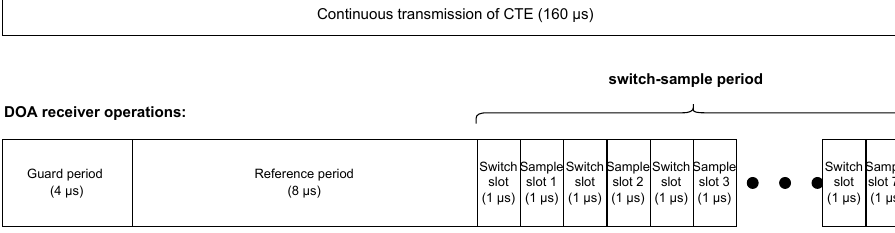
Figure 4. Depiction of the transmitter and receiver